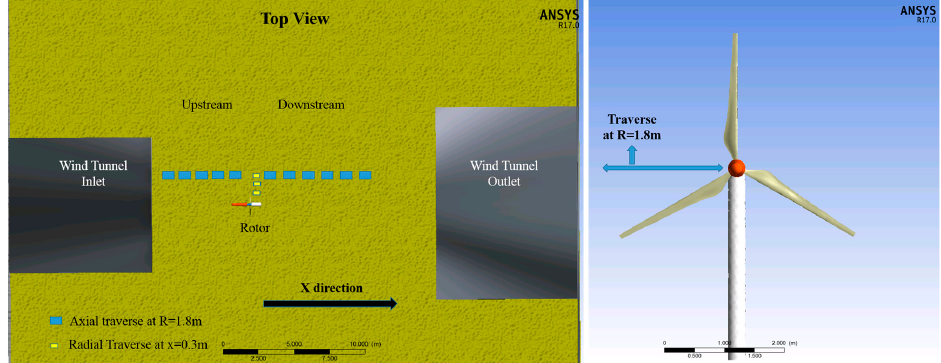
Figure 1. Sketch showing an overview of the MEXICO (Model Experiments in Controlled Conditions) Experiment (Top View).